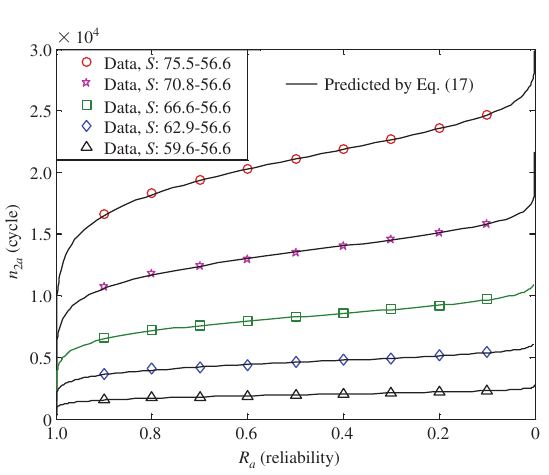
Figure 7 Comparison between the predicted reliability drop and simulation data for composites under various low-high fatigue load- ing